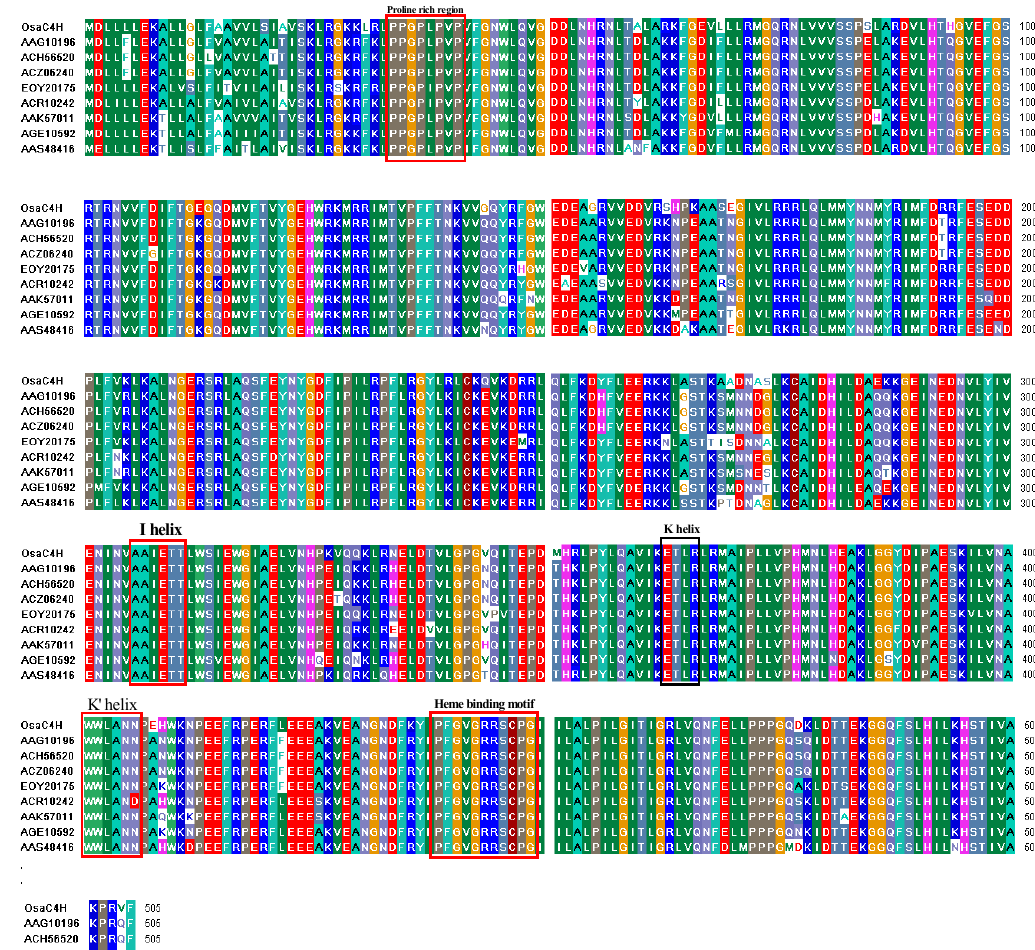
Figure 2. Alignment of the deduced full-length amino acid sequence of OsaC4H with other known C4H reported in reported in Allium cepa (AAS48416), Gossypium arboreum (AAG10196), Theobroma cacao (EOY20175), Canarium album (ACR10242), Gossypium hirsutum (ACZ06240, ACH56520), Citrus x paradise (AAK57011) and Lonicera japonica (AGE10592). P450 specific consensus sequences are